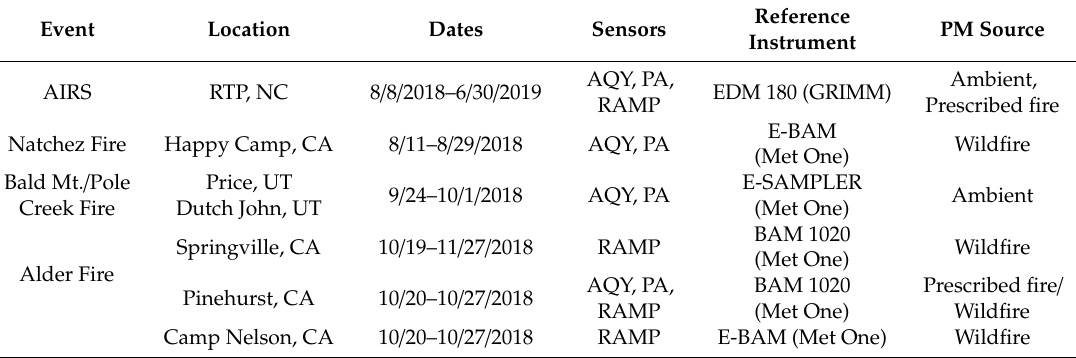
Table 1. List of deployment sites and collocated particulate matter (PM)